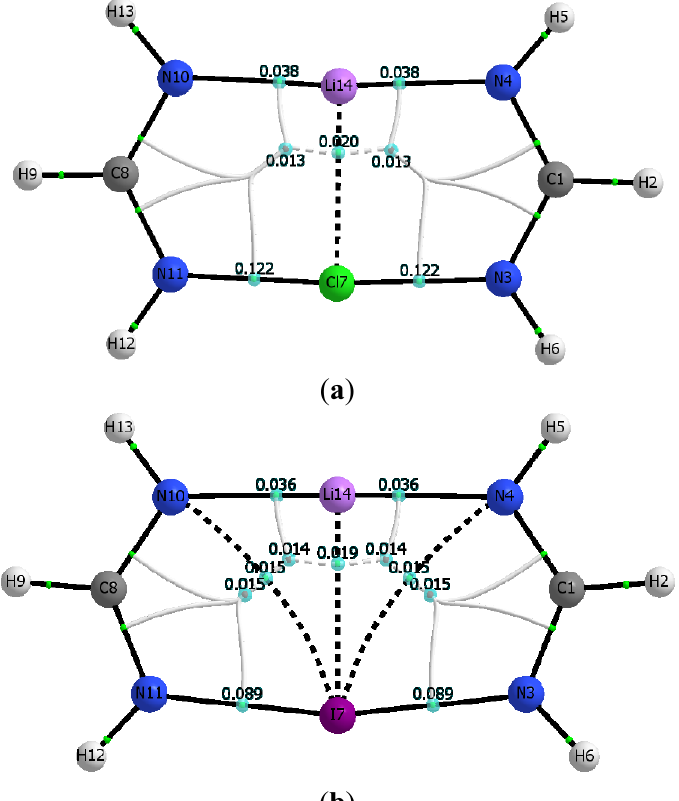
Figure 4. Molecular graph of dimers with C symmetry ( a ) dimer of chlorinated 2v formamidine and lithium formamidinate. ( b ) dimer of iodinated formamidine and lithium formamidinate. Bond critical points, ring critical points, and bond paths are sown. Molecular graphs obtained using B3LYP/aug-cc-pvtz wavefunction obtained from the M06-2X/aug-cc-pvtz optimized